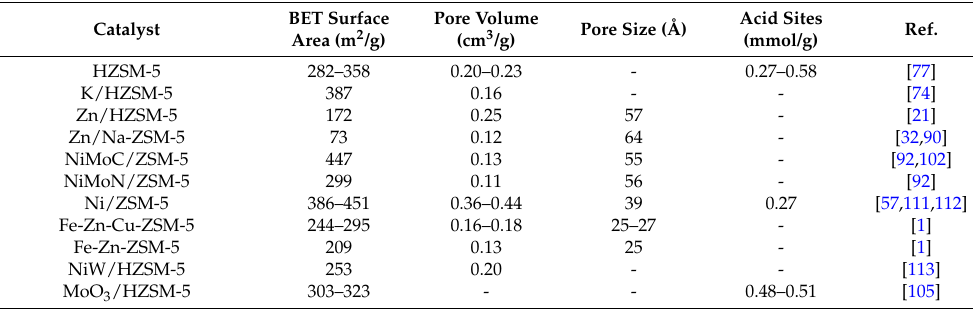
Table 9. The properties of catalysts used in vegetable oil upgrading to